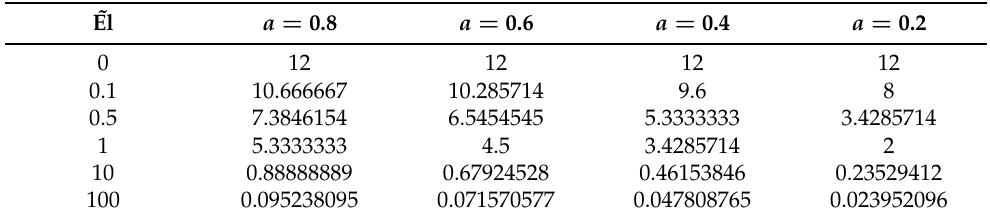
Table 2. Critical values of R.